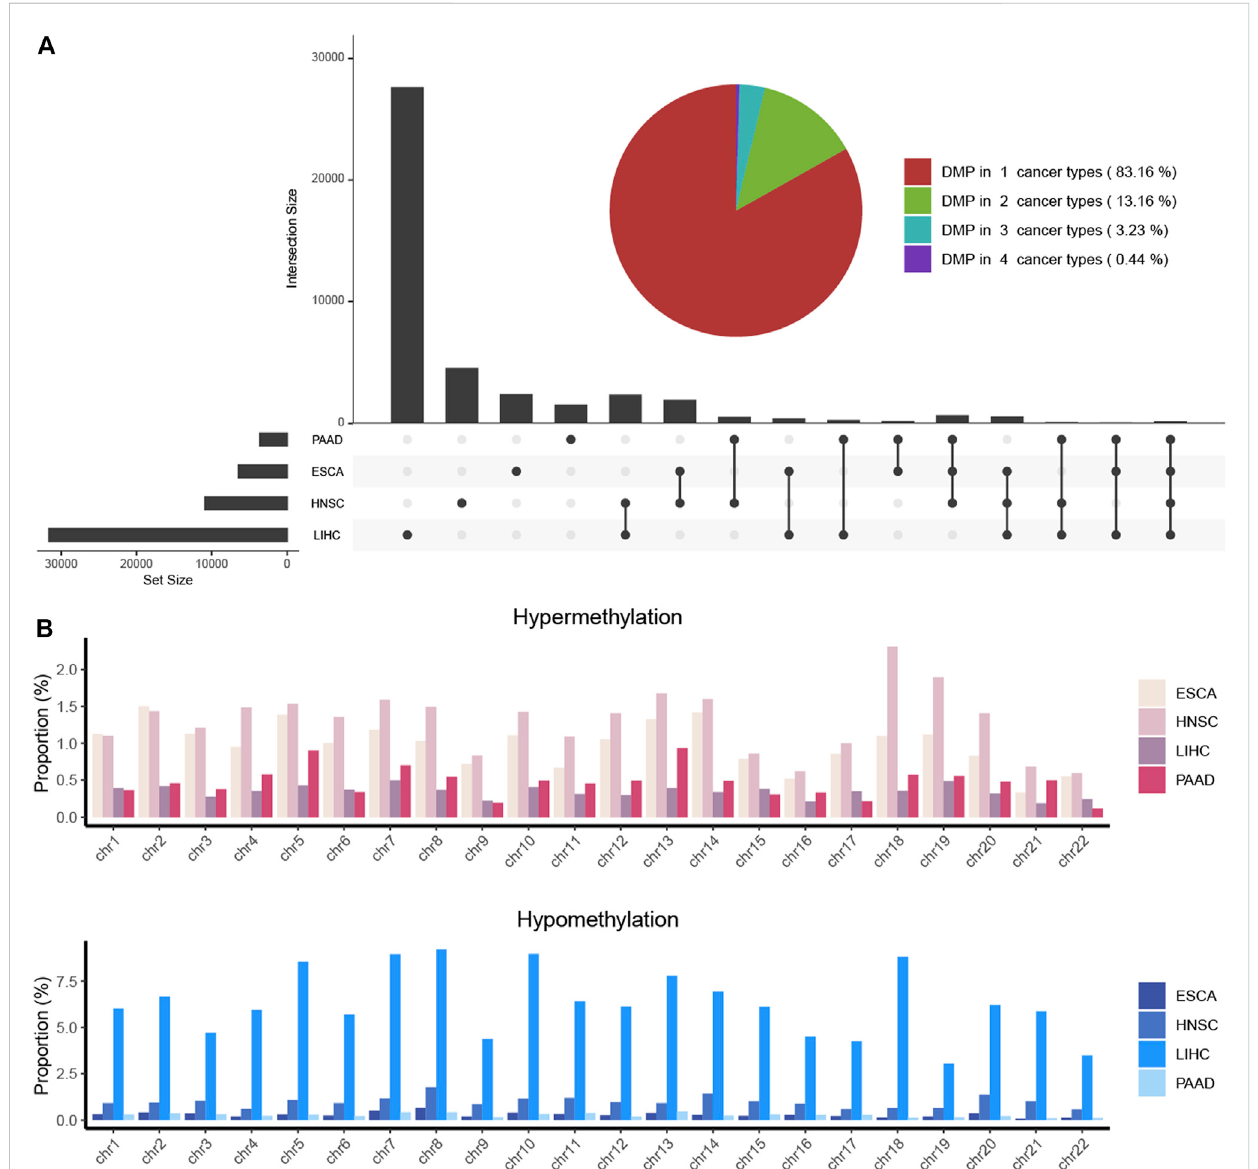
FIGURE 1 DMPswereinvestigatedinfouralcohol-associatedcancers. (A) CombinedplotshowedthenumberofDMPsineachcancertypeandthatofmultiple cancer types. The number of the same DMPs between different cancer types was calculated and shown as the intersection size. (B) . Proportion of hypermethylatedandhypomethylatedDMPslocatedinchromosomesofeachcancertype.Theproportionwasdeterminedastheratioofthenumberof identi fi ed DMPs to the total number of CpG probes on each